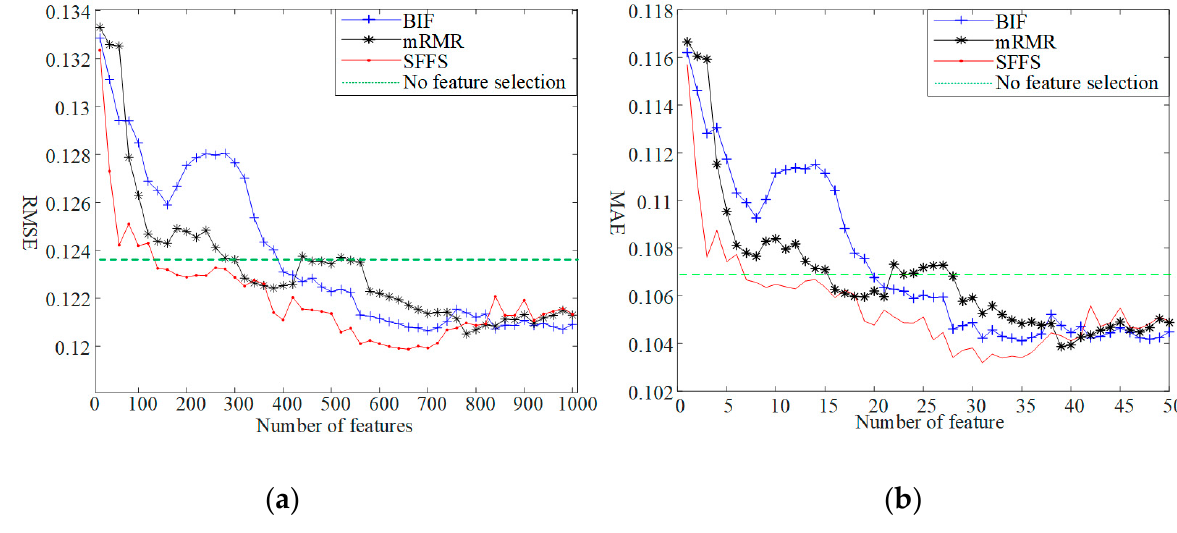
Figure 9. Comparison of the three feature selection methods ( a ) root mean square error (RMSE) of WPP changing with the number of input features; ( b ) mean absolute error (MAE) of WPP changing with the number of input features.